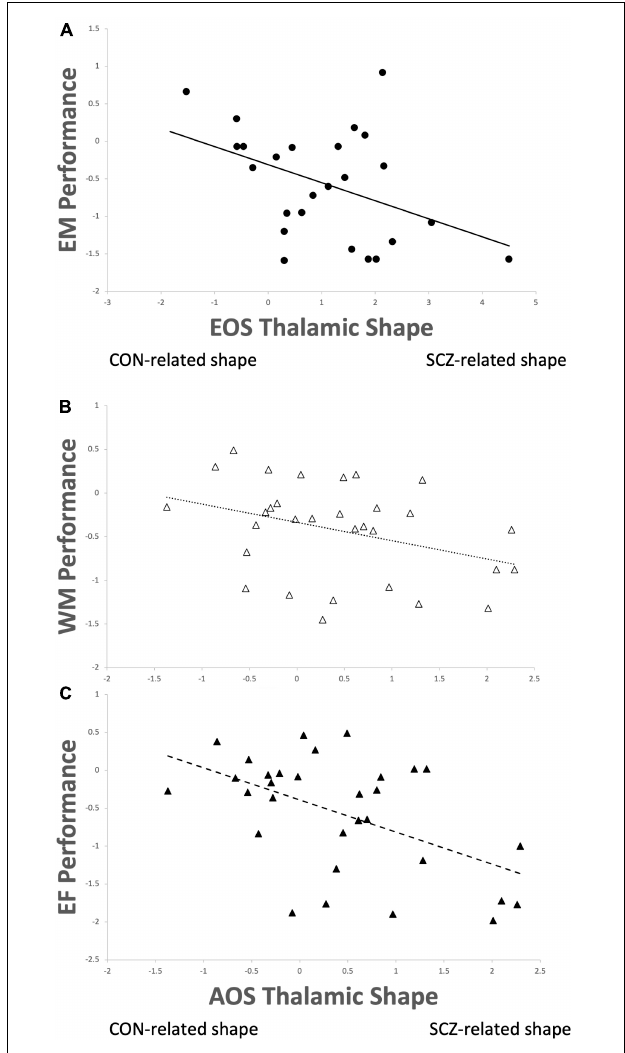
FIGURE 2 | Thalamic shape progressing from healthy control (CON) to schizophrenia (SCZ) correlated with (A) poorer episodic memory performance ( r = –0.43, p = 0.03) in early-onset schizophrenia (EOS); (B) poorer working memory performance ( r = –0.36, p = 0.047) and (C) poorer executive functioning ( r = –0.52, p = 0.003) in adult-onset schizophrenia